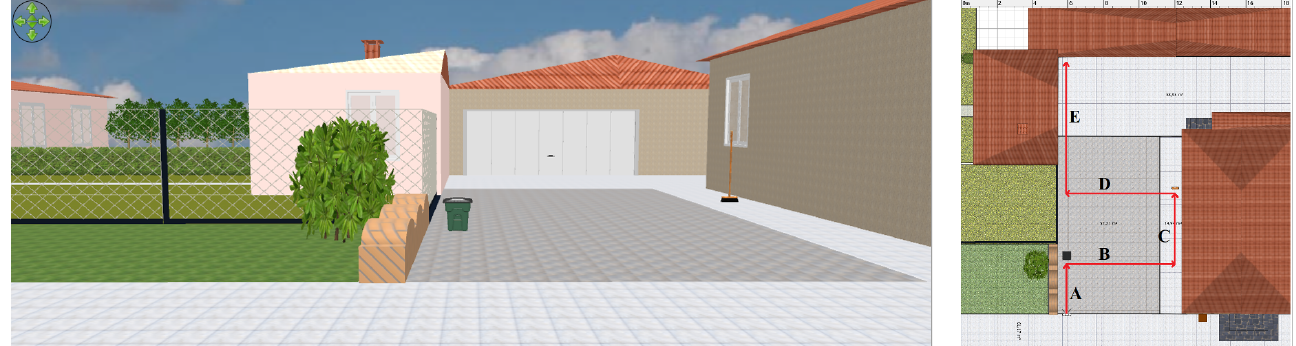
Figure 23. Three-dimensional representation of the backyard, where the red arrows indicate the mixed path followed by the user during the walk.